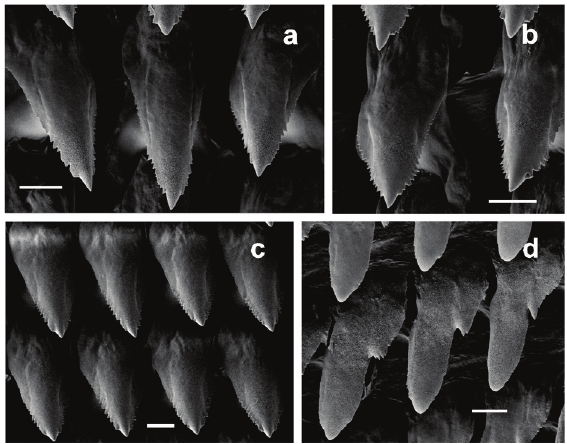
Figure 6 - a , radula of Solaropsis brasiliana , central tooth and first lateral teeth, note the edges serrated. b , forth lateral teeth to the right side of central tooth. c , lateral teeth to the left side of central tooth. d , marginal bicuspid teeth. Scale bar=